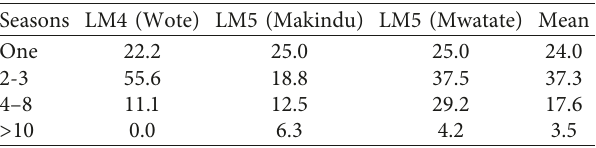
Figure 2: Percentage of farmers obtaining cowpea seeds from different sources in various agroecological zones in Makueni and Taita Taveta during the 2016 long rains. Table 1: Percentage of farmers using cowpea seeds for indicated seasons in various subcounties in Makueni and Taita Taveta during the 2016 long